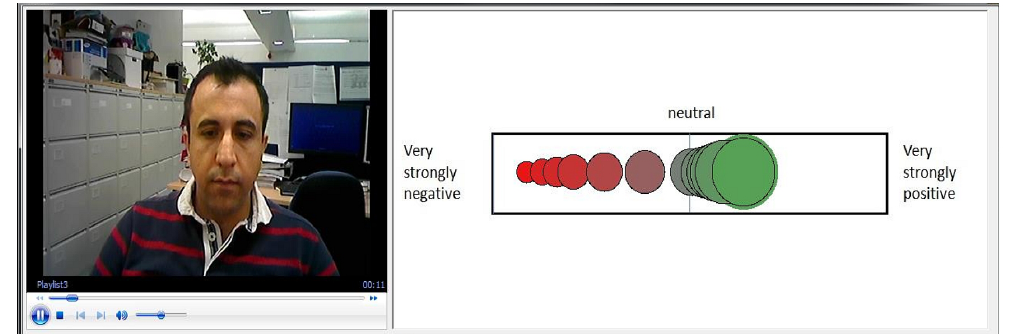
Figure 1. Video annotation process for valence using FeelTrace software. The video were shown on the left and the emotion labels were made by moving the mouse on the